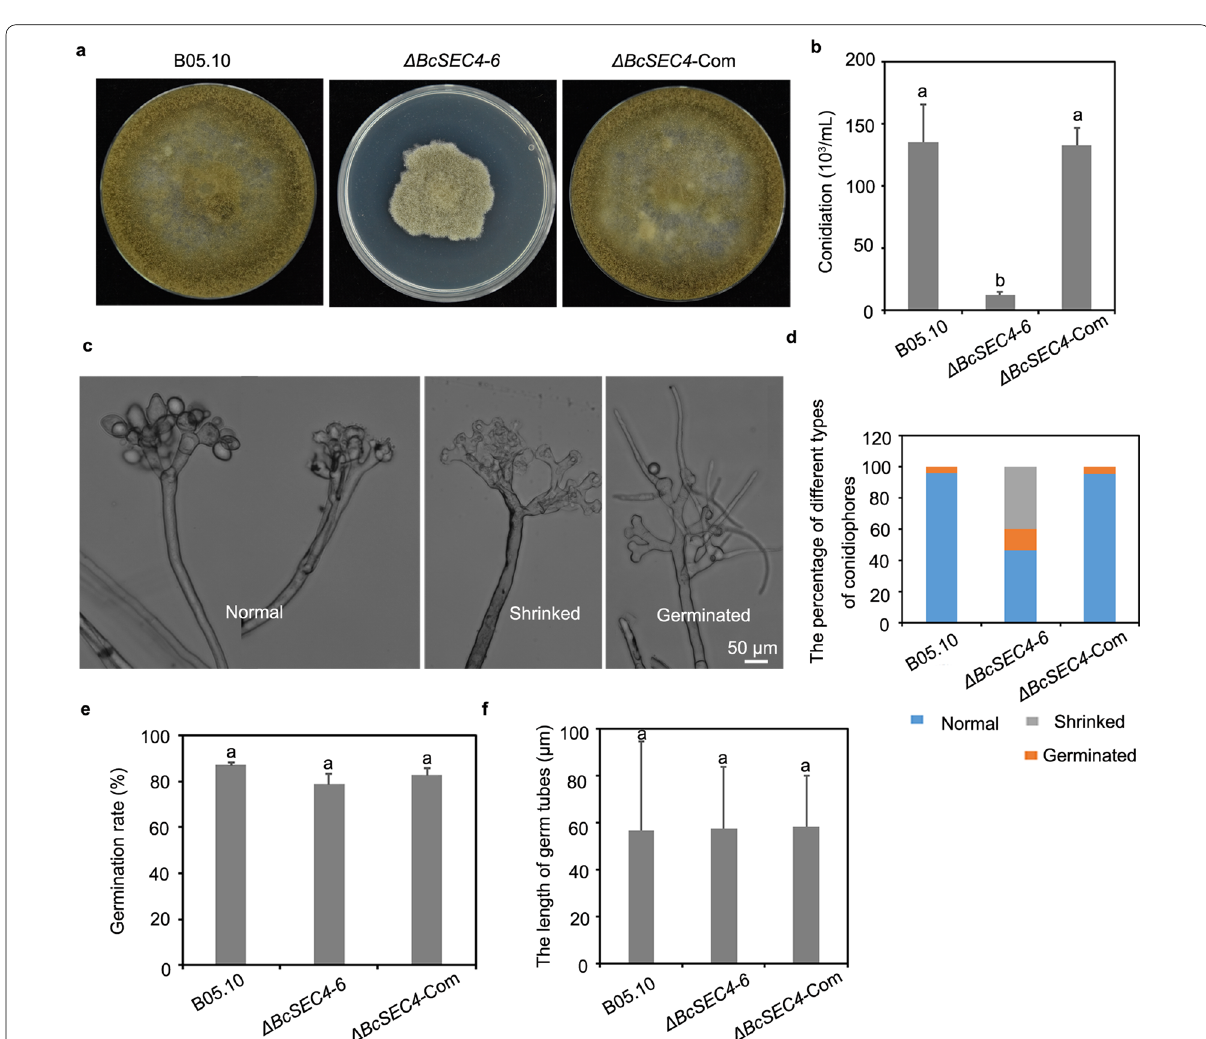
Fig. 1 BcSec4 is required for conidiation of B. cinerea . a Conidial production of B05.10, the ΔBcSEC4 mutant, and complemented strains observed on PDA plates at 25 °C for 7 days. b Conidiation capacity of the indicated strains. Conidia were harvested from PDA plates after incubation for 7 days at 25 °C. c Conidiophore morphology of the ΔBcSEC4 mutant on PDA plates for 7 days. d Percentage of abnormal conidiophores produced by the indicated strains. More than 100 conidiophores of each strain were measured in each experiment. e Germination rates examined under a microscope after 12 h of incubation in YEPD liquid medium. f The lengths of germ tubes examined after 12 h of incubation in YEPD liquid medium. All data are represented as means standard deviations (SDs) from three independent experiments with triplicate slides examined for each ± treatment. Different letters indicate statistically significant differences ( P <